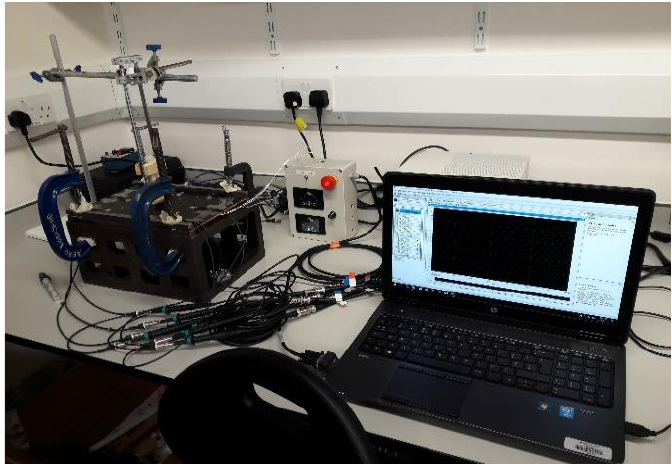
Figure 3. Experimental setup for impact data collection.